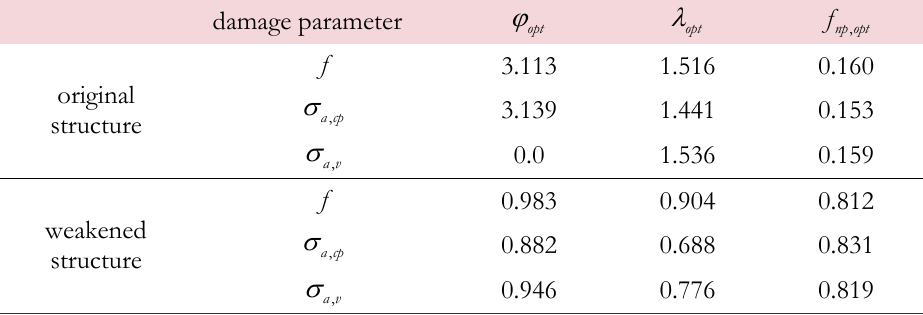
Table 1: Results of the optimization.